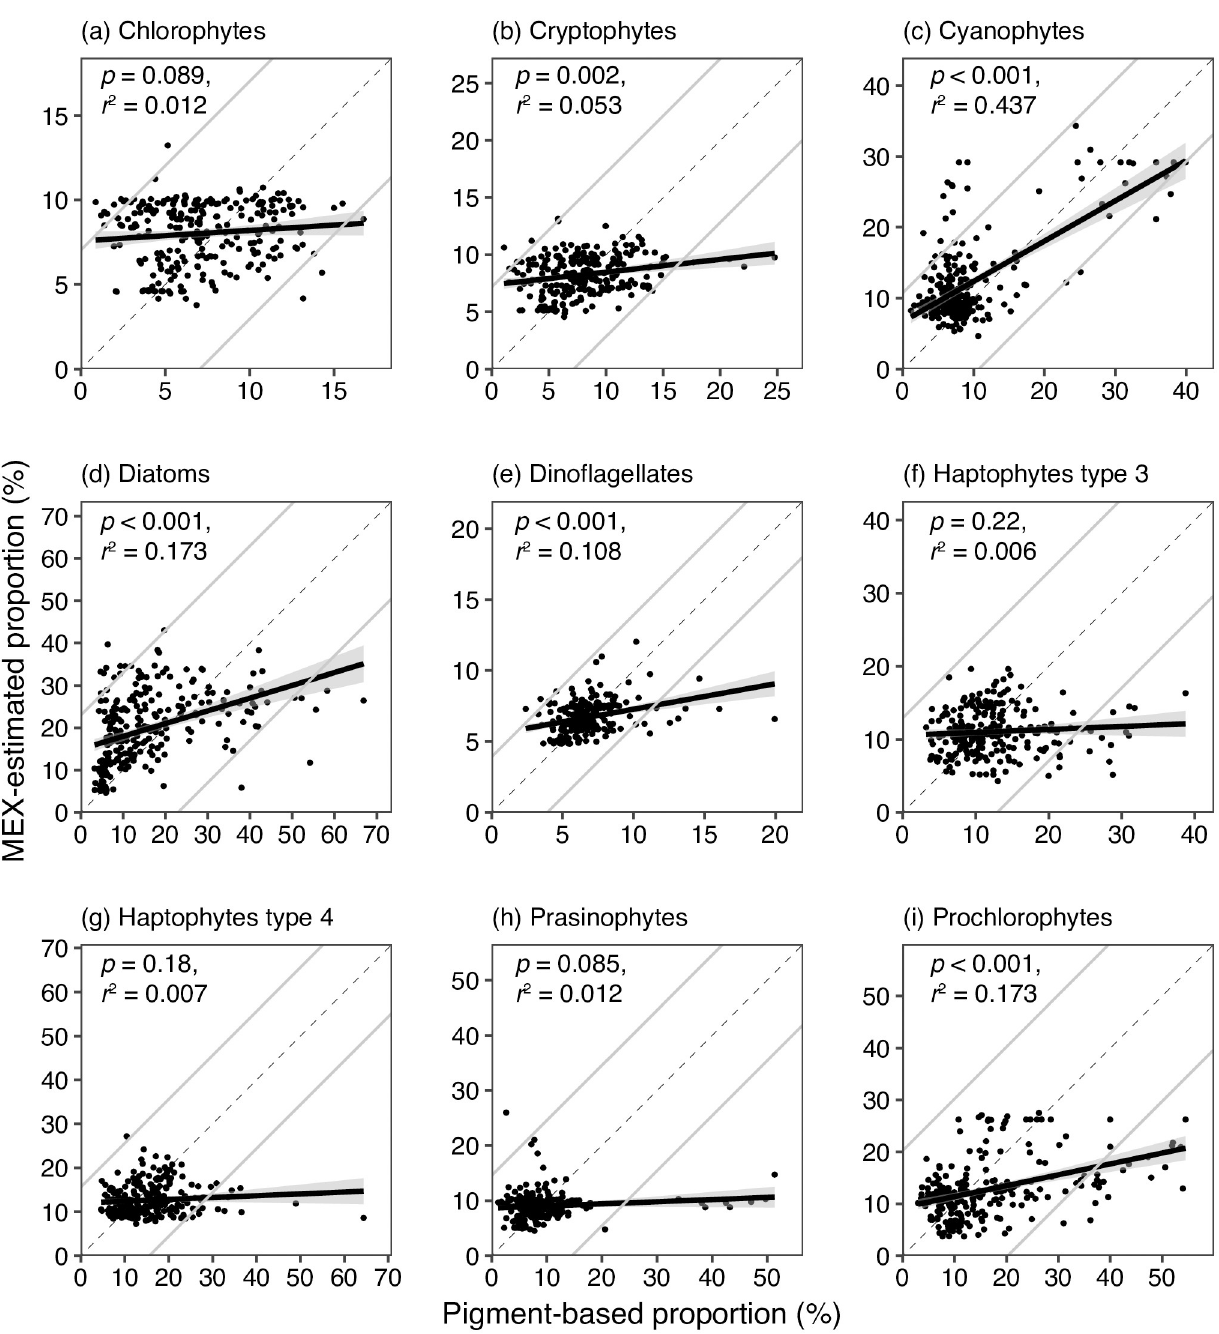
Fig 4. Same scatter plots with Fig 2, but MEX-estimated phytoplankton proportions (%) were based on the database ( U 2), which removed the data collected in the same area from U . Comparisons were performed in nine chemotaxonomic phytoplankton groups (chlorophytes, cryptophytes, cyanophytes, diatoms, dinoflagellates, haptophyte type 3, haptophyte type 4, prasinophytes, and prochlorophytes). The dashed and the bold lines with shadow denote the 1:1 line and the linear regression line with standard errors regression analysis, respectively. The gray lines indicated 95% confident intervals of the differences between MEX-based and plant pigment-based